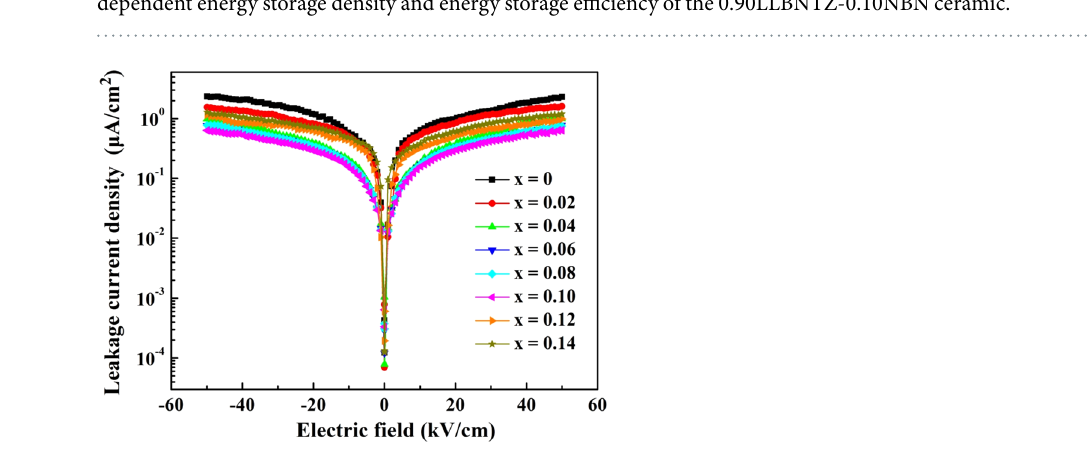
Figure 11. Leakage current density as a function of applied electric field for the (1-x)LLBNTZ-xNBN